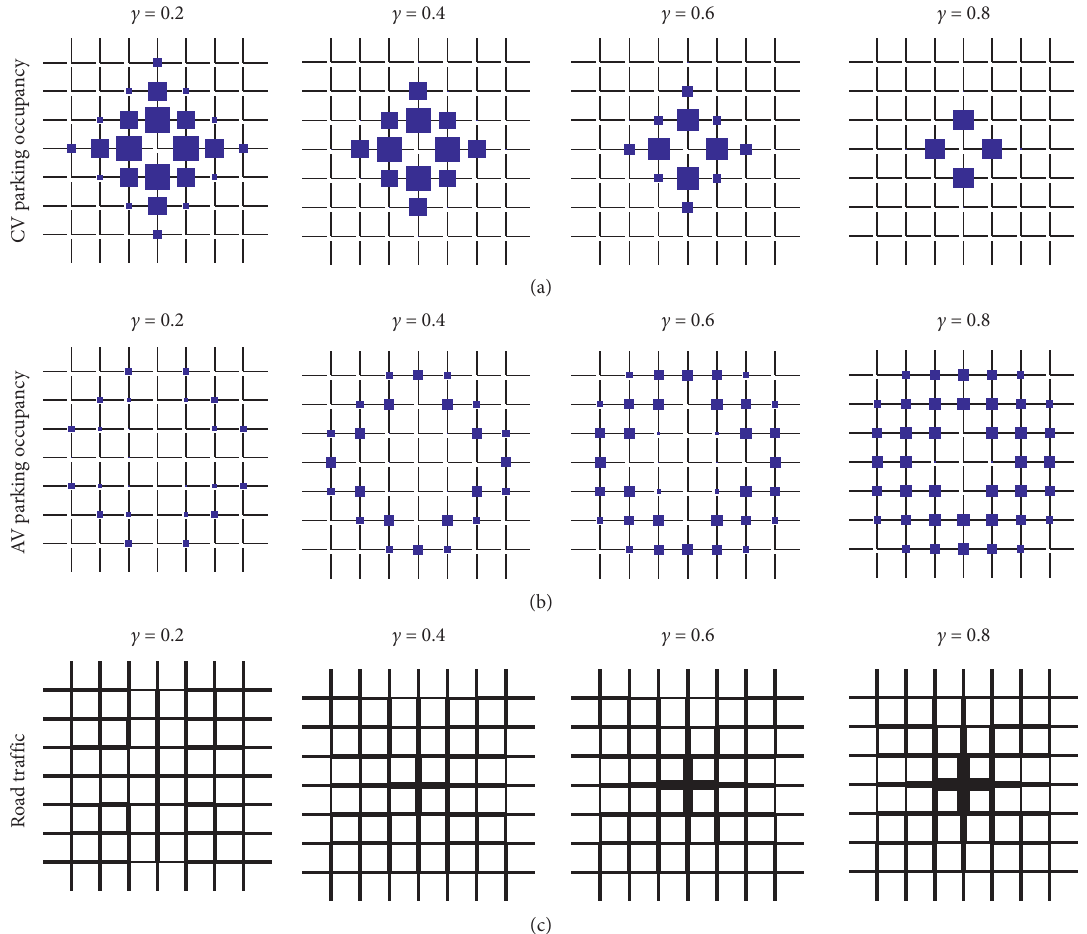
Figure 14: (a) Parking occupancy of conventional vehicles, (b) parking occupancy of autonomous vehicles, and (c) road traffic. The size of the squares in panels a-b shows the extent of parking occupancy. Similarly, the thickness of the lines in panel c represents the level of traffic on each